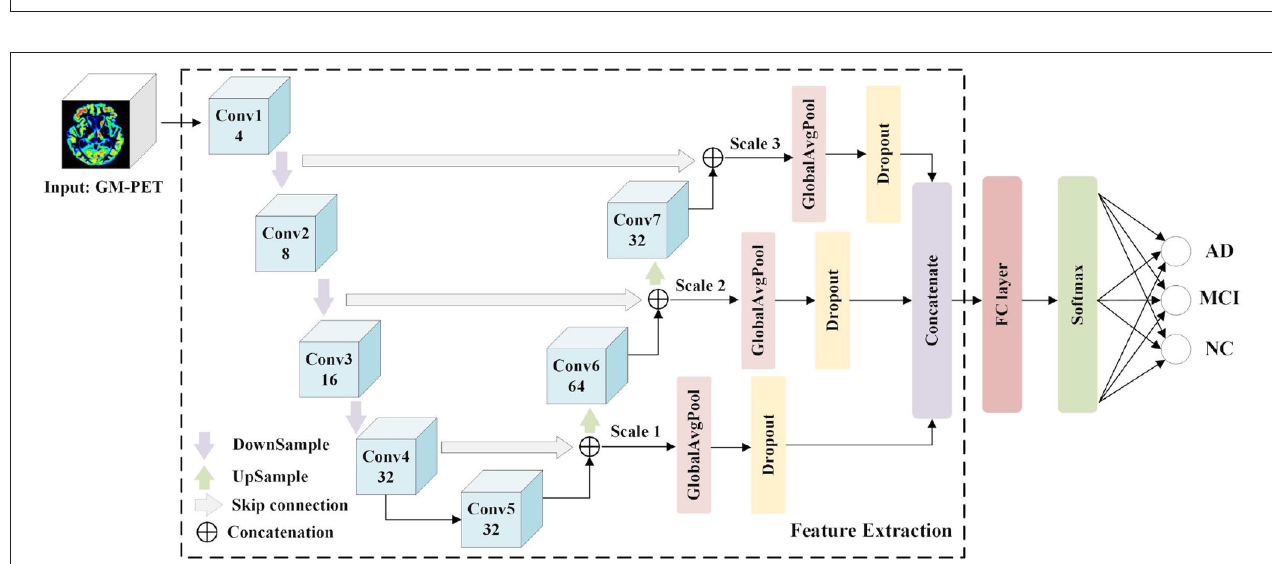
FIGURE 4 | 3D Multi-Scale CNN architecture for AD